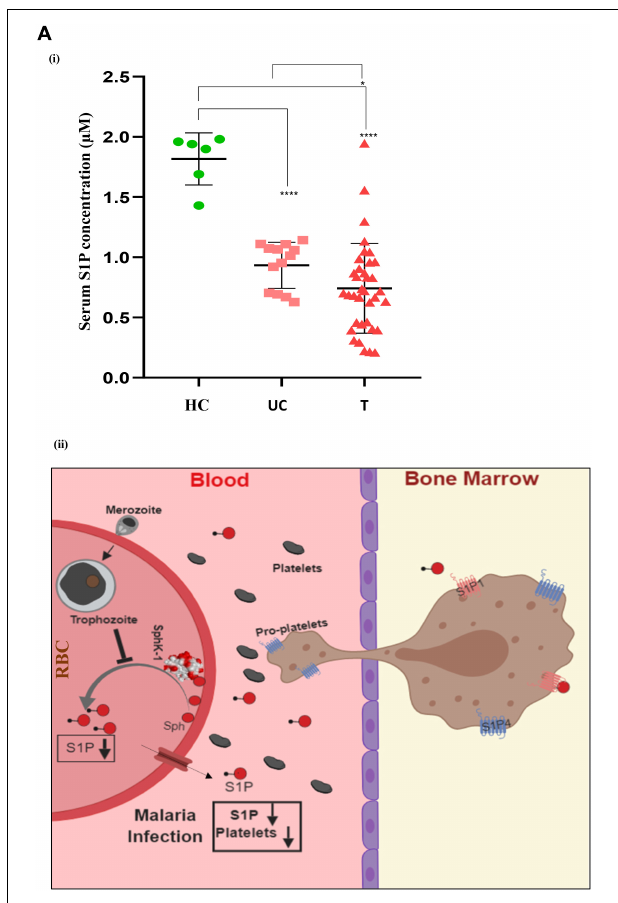
FIGURE 5 | One-way ANOVA with Tukey’s multiple comparisons analysis among three groups, namely, healthy control (HC), uncomplicated malaria (UC), and thrombocytopenia patients (T). (A) (i) Comparative analysis among the groups, namely, HC ( N = 6) and UC ( N = 13), HC ( N = 6) and T ( N = 35), and UC ( N = 13) and T ( N = 35) was done with one-way ANOVA followed by Tukey’s post hoc test, which revealed significant differences with p- values: **** p < 0.0001, **** p < 0.0001, and * p < 0.05 respectively. (ii) Working model: role of erythrocytic SphK-1 in decreasing serum S1P and platelet levels. P. falciparum infection to human erythrocyte attenuates the erythrocytic SphK-1 by regulating its level and phosphorylation. In turn, SphK-1 modulates S1P production, hence, reducing its concentration in the blood. S1P gradient is altered during the malaria infection inhibiting the S1P/S1P receptor (S1P1 and S1P4) signaling pathway in the megakaryocytes. This results in decreased platelets shedding from the megakaryocytes and leading to clinical parameters like thrombocytopenia and anemia associated with disease